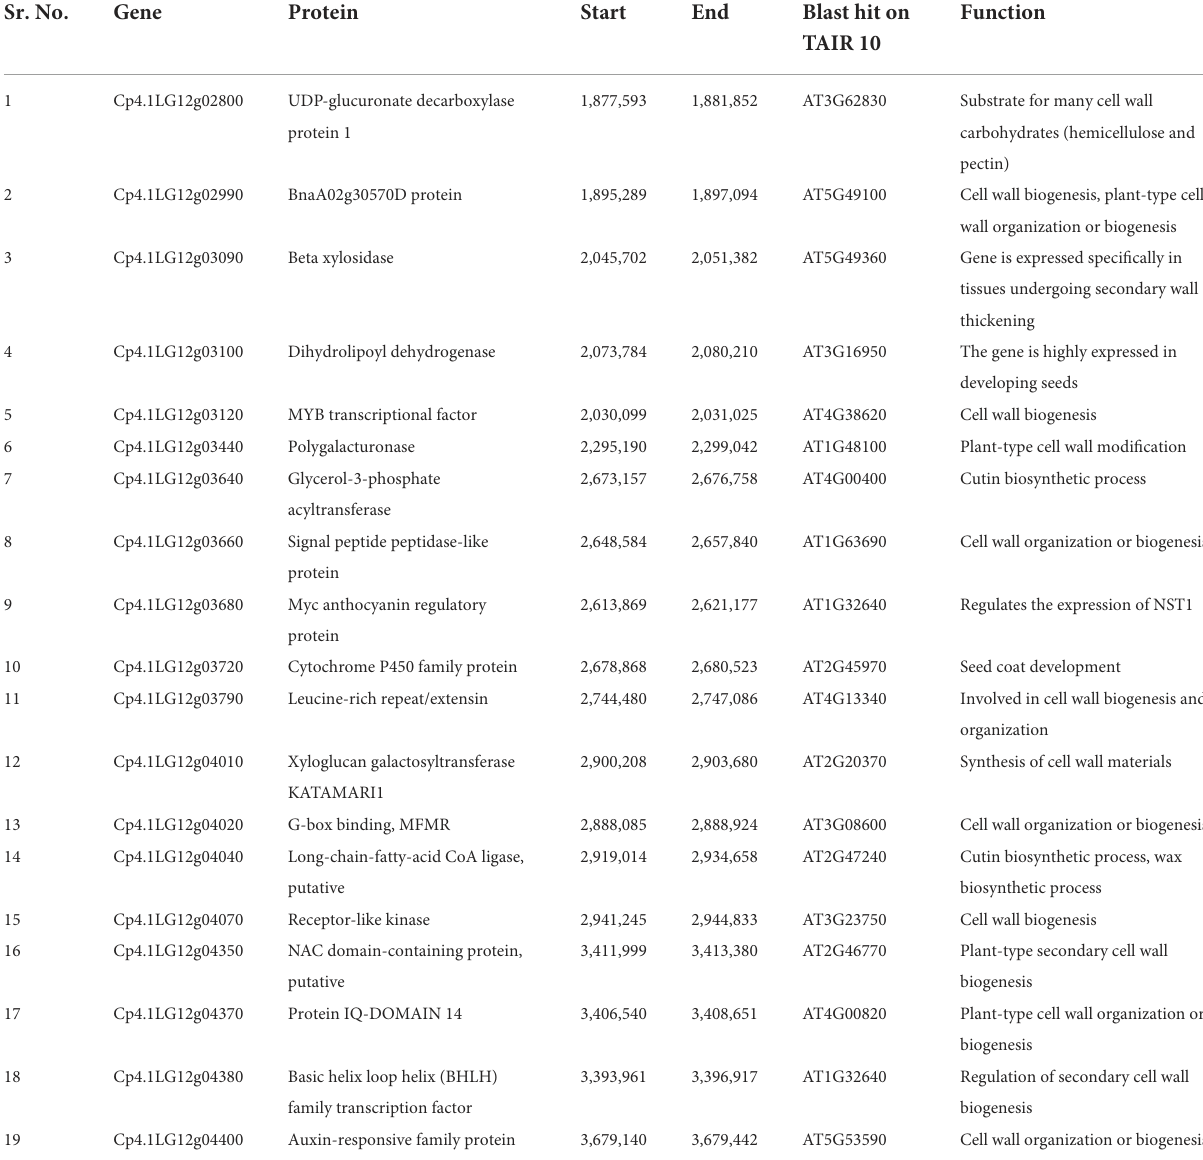
TABLE 3 List of genes associated with the cell wall, lignin, or cellulose biosynthesis from the candidate region governing hull-less seed trait. Sr.